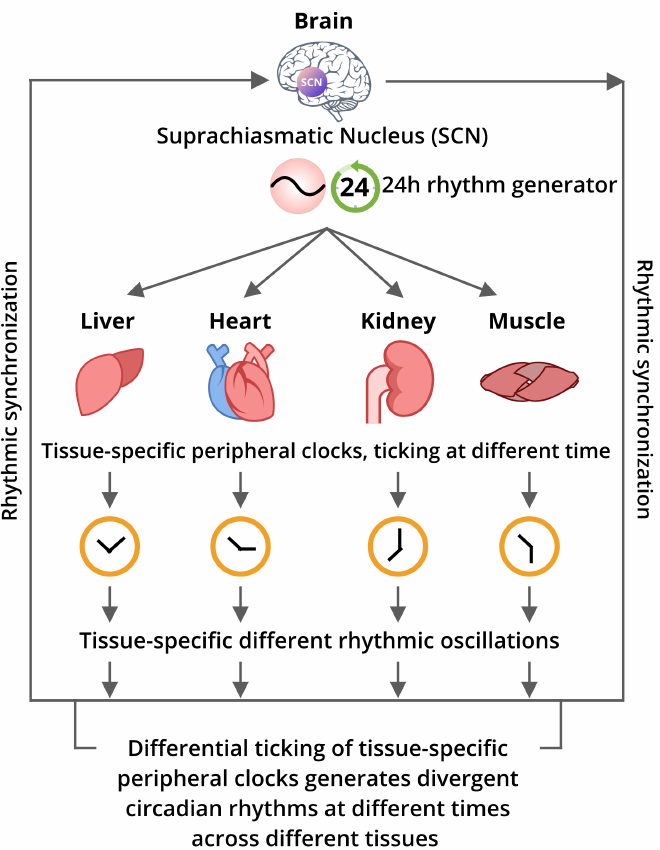
Figure 3. A representative connectome of the master clock and tissue-specific peripheral clocks. The primary rhythmic oscillation that is usually produced at the master clock is transduced to different tissues through the humoral and neural connectivities. The peripheral clocks preserve their own local timing and reproduce differential rhythmic oscillations, and thus differential circadian outputs. There may exist a tricky rhythmic synchronization mechanism among those peripheral clocks with the master pacemaker to establish the circadian